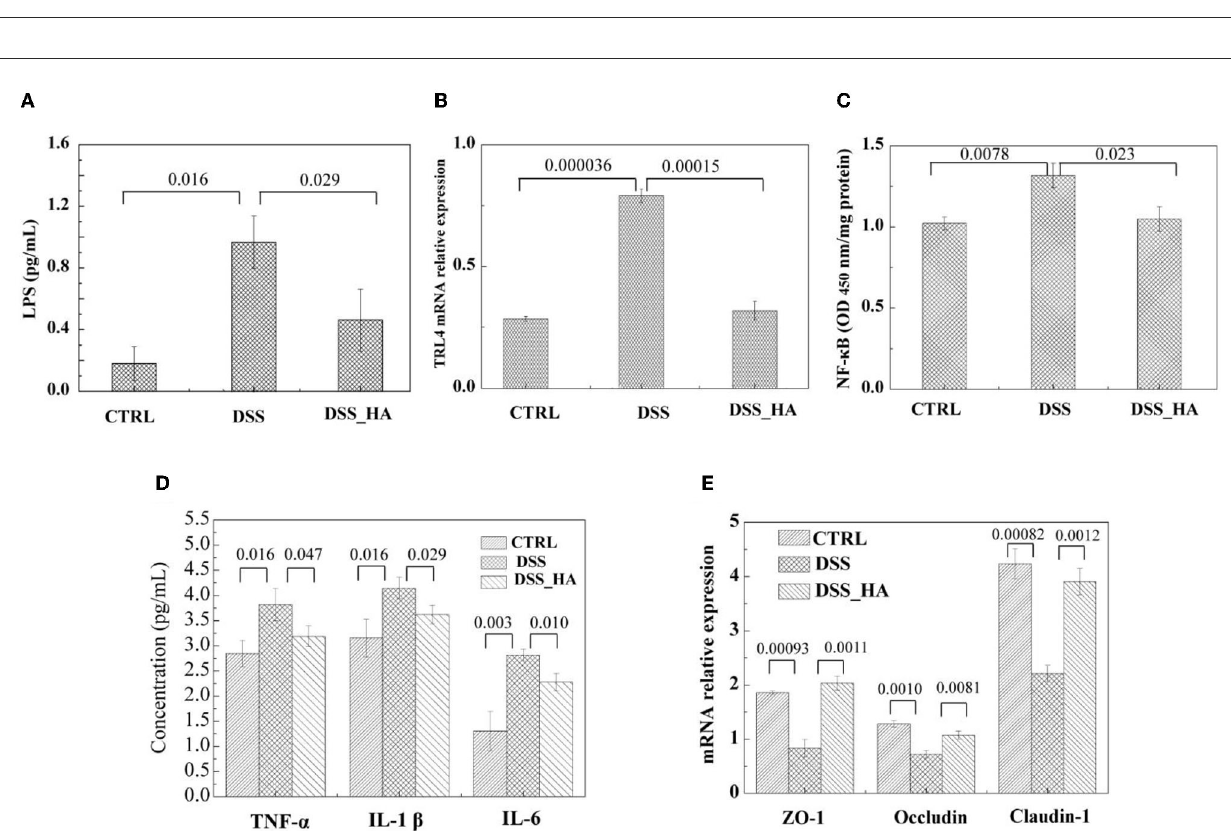
FIGURE4 HAs protected mice from inflammatory bowel disease induced by DSS exposure. (A) Lipopolysaccharide (LPS) concentration in the serum of the mice in each group. (B) Relative Toll-like receptor 4 (TLR4) expression level in the colon tissue of each group. (C) NF- κ B level in the colon tissue of each group. (D) Comparison of the TNF- α , IL-1 β , and IL-6 concentrations in the mice sera of the three groups. (E) Relative expression level of ZO-1 , occludin , and claudin-1 in the colon of the three groups. The p -values from (A–E) are shown at the top of the histogram.